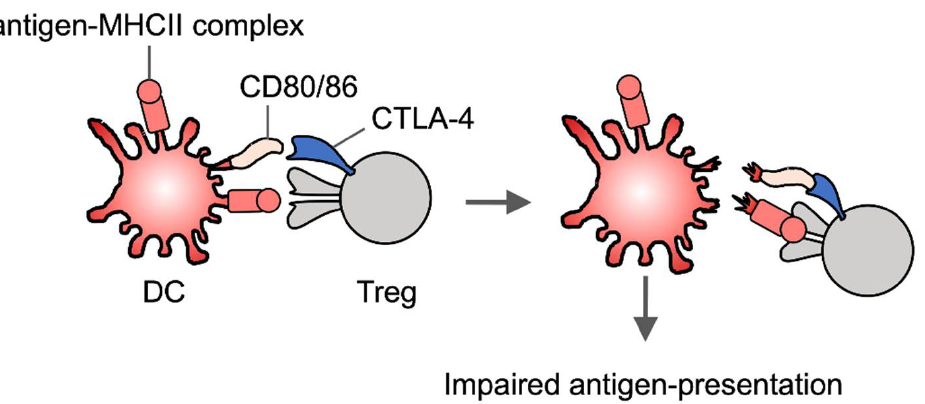
Figure 4. Trogocytosis in Treg-mediated immune suppression. Treg cells strip off MHCII and costimulatory molecules from DCs and as a result these DCs have an impaired antigen-presenting activity.